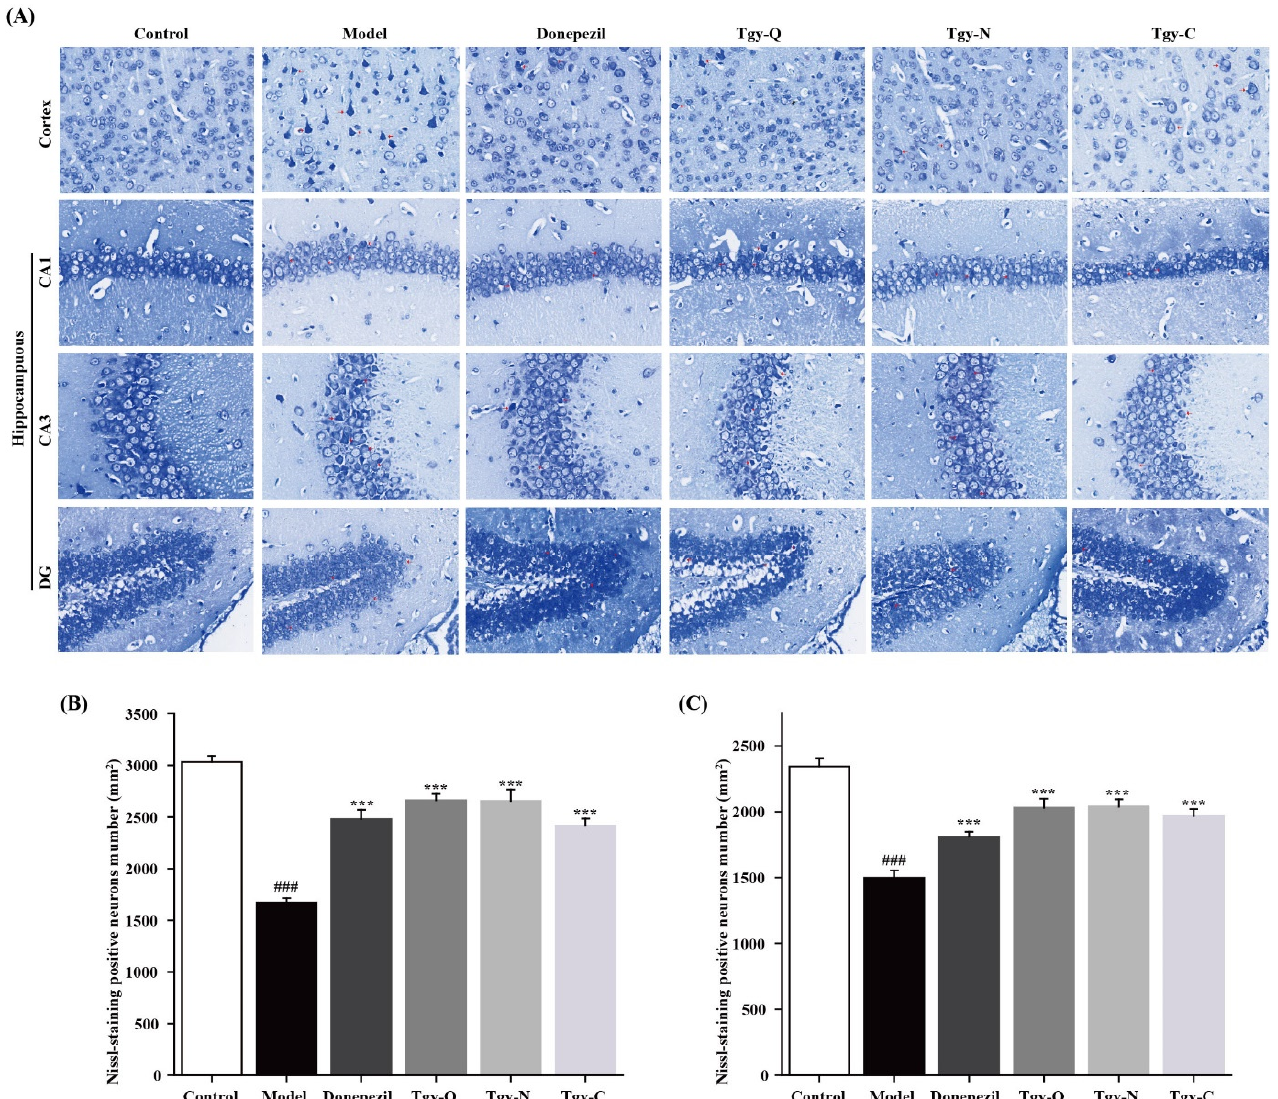
Figure 4. Nissl histochemical stain for Nissl bodies in the neurons of cortex and hippocampus in different mouse groups. ( A ) Nissl staining images of cortex and hippocampus (×400 magnification). ( B ) Cortical Nissl body statistics chart. ( C ) Nissl body number in hippocampus. n = 3 for each group. ### p < 0.001 different from control group. *** p < 0.001 different from model group.